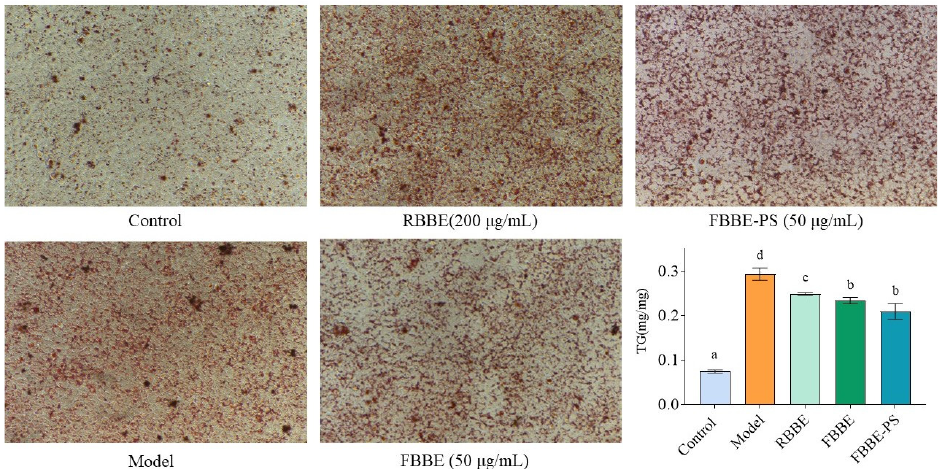
Figure 2. The micrographs (200 × ) of Oil Red O-stained cells and TG contents in HepG2 cells treated with 200 μ g/mL of RBBE, 50 μ g/mL of FBBE and 50 μ g/mL of FBBE-PS. Data are presented as means ± SD, n = 5, different letters indicate significant differences between groups ( p < 0.05).